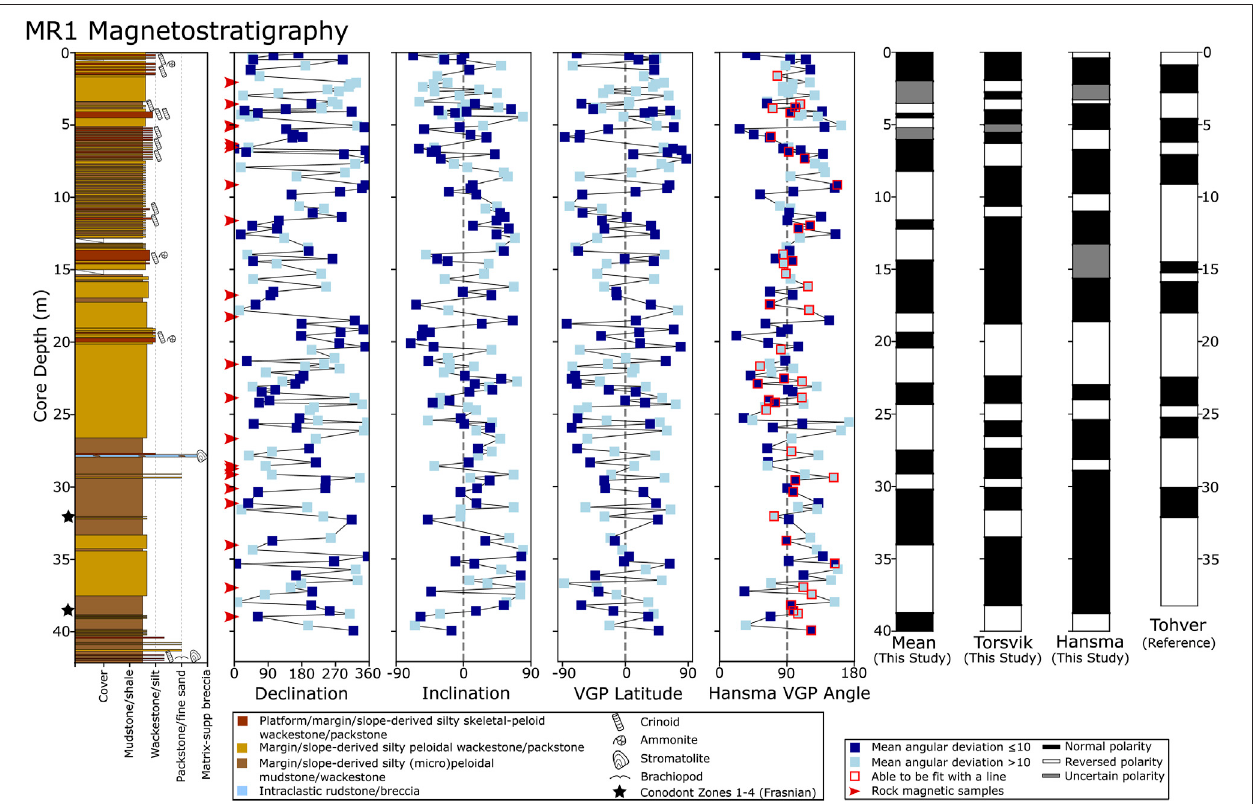
FIGURE 4 | Paleomagnetic directional data and magnetostratigraphy for MR1. Lithologic log, declination, inclination, and virtual geomagnetic pole (VGP) latitude dataforthehigh-temperaturecomponentsofMR1.Thelithologiclogismodi fi edfrom Playtonetal.(2016)and showsfossilsand biostratigraphicmarkersinthesection. Red arrows indicate the 21 locations where samples were taken for rock magnetic analysis. In the fi fth column, the VGPs are plotted as an angle from the paleopole calculated byHansmaet al. (2015) for the Canning Basin; samplesthatcould be fi t withalinegoingto theorigininsteadofan anchored lineare outlined in red. The same calculations and plotting were done using the angle from the mean VGP of the dataset and from the pole calculated by Torsvik et al. (2012) for Gondwana at 370 Ma ( Supplementary Figure S3 ). The magnetic reversals determined from each of these different datasets were used to create a corresponding magnetostratigraphic record. For the magnetostratigraphic record that used the Hansma et al. (2015) paleopole, the meterage of the polarity changes is listed in Supplementary Table S1 . The magnetostratigraphy for MR1 published in Playton et al. (2016) is labelled as Tohver data and compared to the magnetostratigraphy producedhere.TheHansmaetal.(2015),Torsviketal.(2012),Playtonetal.(2016)recordsareallfairlysimilar,thoughtherearesomedifferencesbetween9 mand16 m and below 33 m. The mean VGP interpretation is signi fi cantly different from the others.